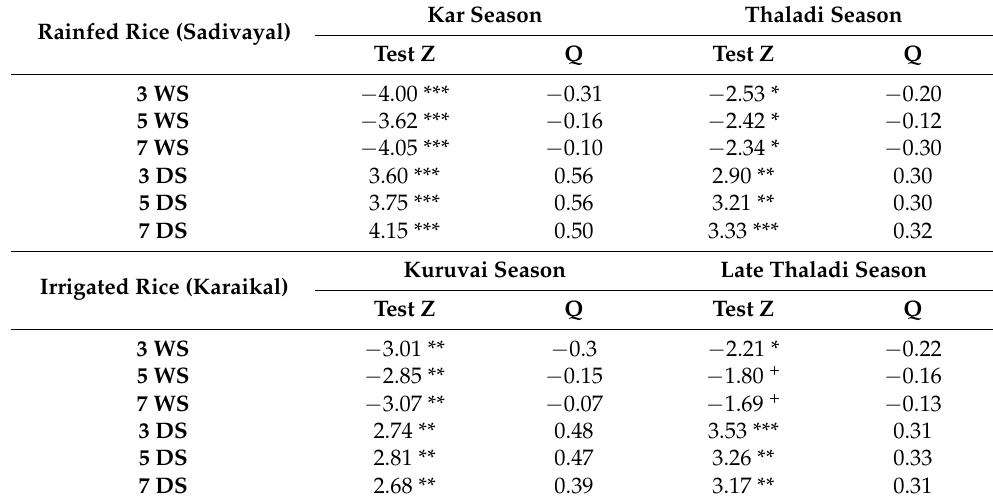
Table 4. Characteristics of dry and wet spells during major rice-growing seasons in Sadivayal and Karaikal.